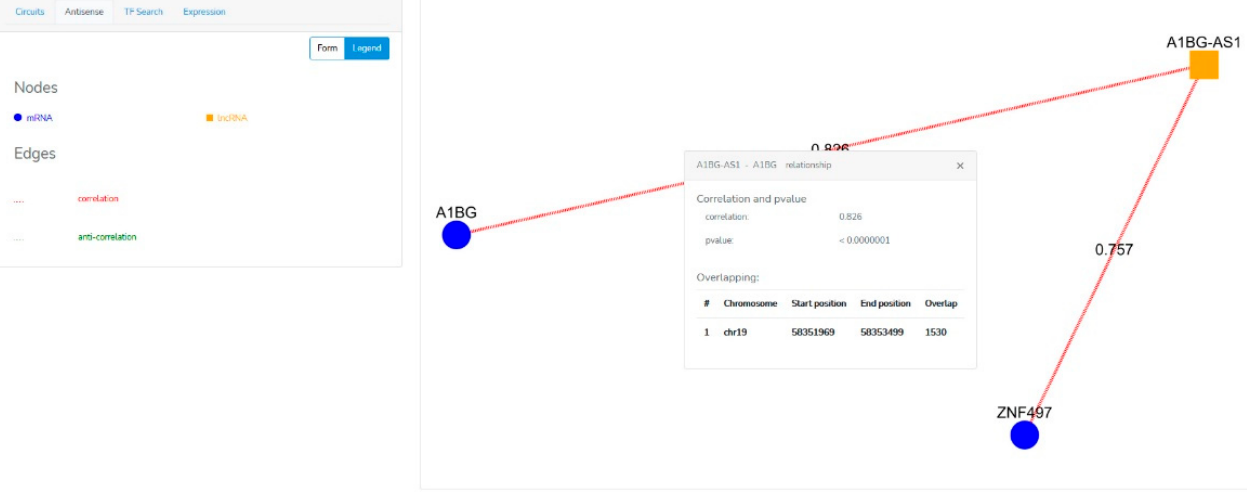
Figure 4. Results section of the VECTOR database for the “Antisense” query. Output data based on gene overlapping and expression correlation are depicted as an interactive network. A pop-up window appears by clicking on the edge and shows expression correlation, p-value and details about the overlapping of the mRNA lncRNA pair.